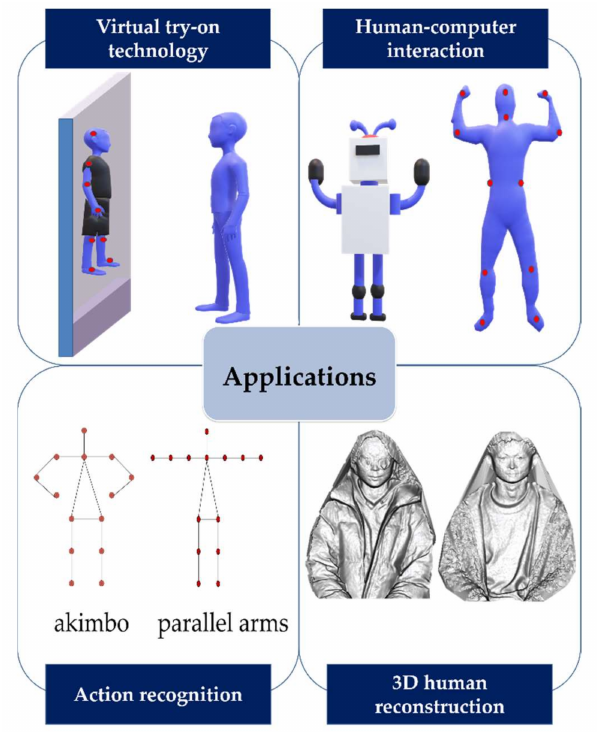
Figure 13. Applications of point cloud-based joint